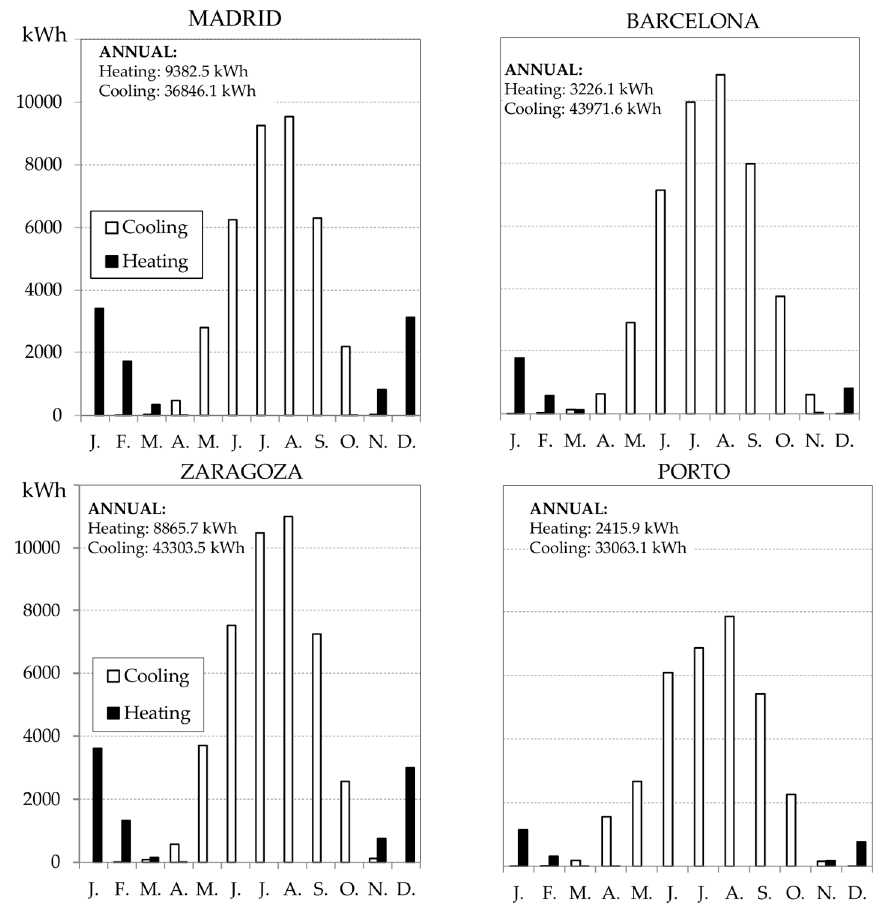
Figure 3. Energy demand for air conditioning in the office building in: Madrid, Barcelona, Zaragoza, Porto.